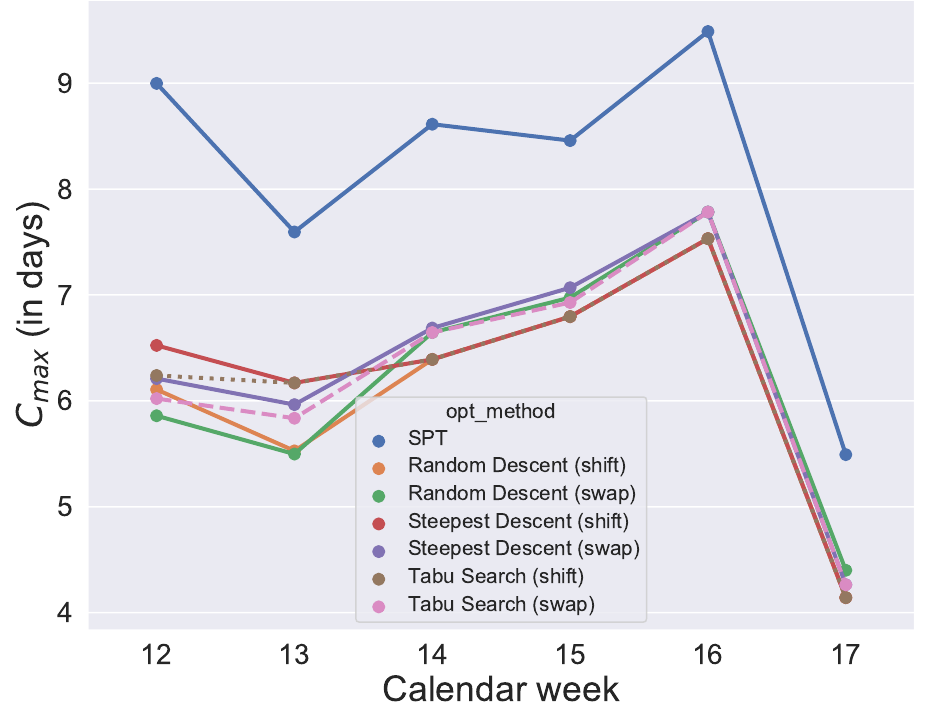
Figure 8. Optimization results for quantile 60%.